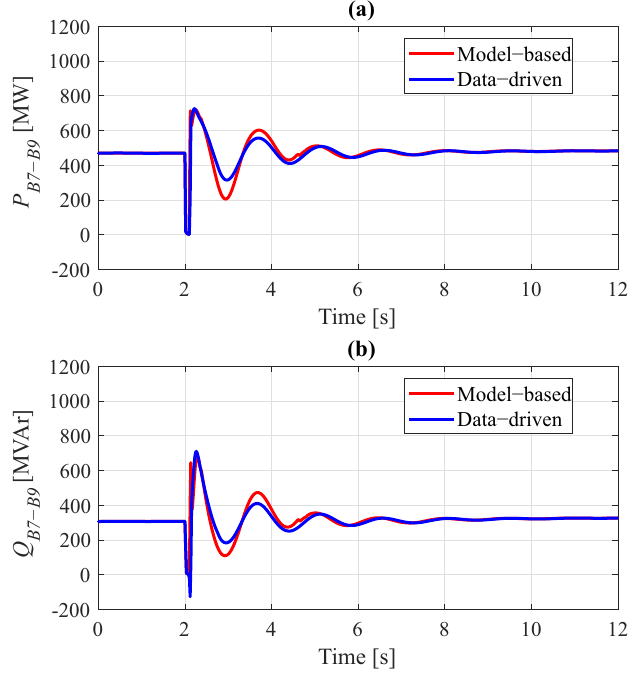
Figure 10. Power flow during a fault at Bus 7: ( a ) active power, and ( b ) reactive power. On the other hand, a STATCOM not only offers the capability to improve the power system efficiency due to its fast dynamic response of voltage control but can also help to mitigate low-frequency power oscillations [38]. For example, Figure 11 displays the difference between two rotor angles corresponding to Generator 1 and Generator 2